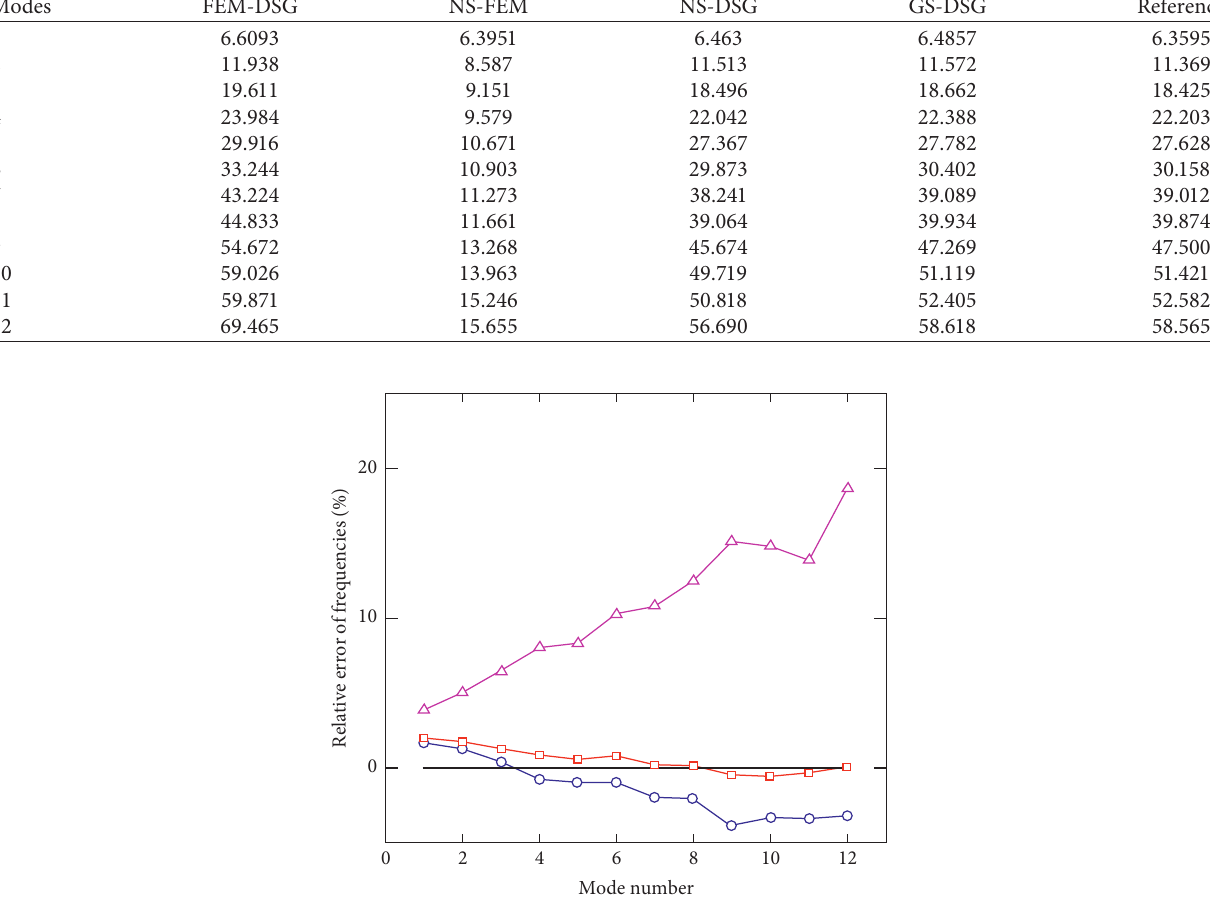
Table 8: First 12 parameterized natural frequencies ω of the elliptical plate with 446 nodes.